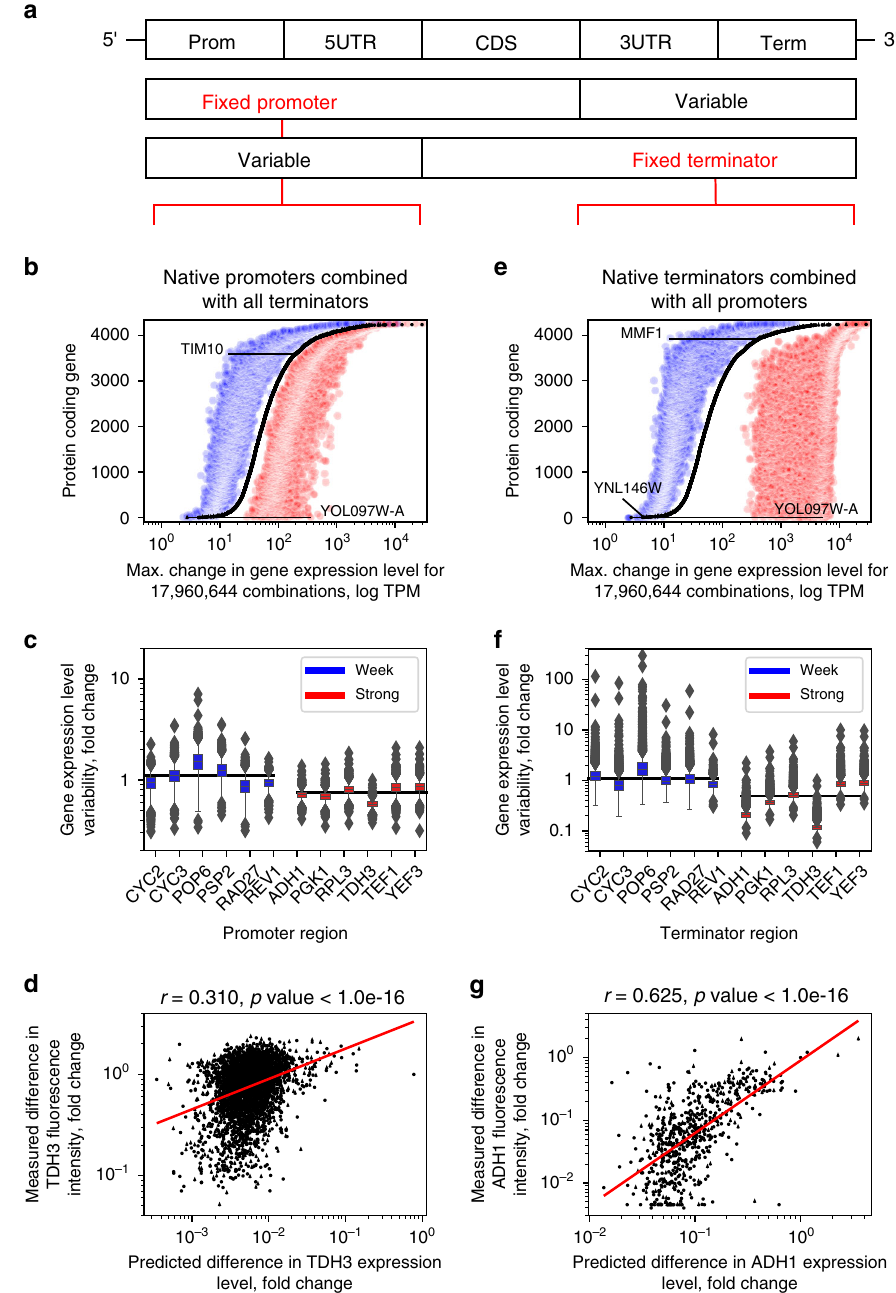
Fig. 5 Each gene is predicted to contain a large degree of regulatory freedom for expression engineering. a Two global halves of the gene regulatory structure where 5 ′ -UTRs were combined with promoters and 3 ′ -UTRs with terminators. b Maximum increases (red) and decreases (blue) of gene expression levels with combinations of 4238 native promoters with all terminator variants. c Distributions of gene expression levels for combinations of either strong (red) or weak (blue) promoters with all terminator variants ( n = 4238 for each construct). Black lines denote median exp. levels. d Comparison of changes in predicted TDH3 expression levels with measured fl uorescence intensities when combining the promoter with n = 4005 terminator variants 45 . Red line denotes least squares fi t. e Maximum increases (red) and decreases (blue) of gene expression levels with combinations of 4238 native terminators with all promoter variants. f Distributions of gene expression levels for combinations of either strong (red) or weak (blue) terminators with all promoter variants ( n = 4238 for each construct). Black lines denote median expression levels. g Comparison of changes in predicted ADH1 expression levels with measured fl uorescence intensities when combining the terminator with n = 625 promoter variants 44 . Red line denotes least squares fi t. For box plots in c , f , boxes denote interquartile (IQR) ranges, centres mark medians and whiskers extend to 1.5 IQR from the quartiles. Source data are provided as a Source data fi